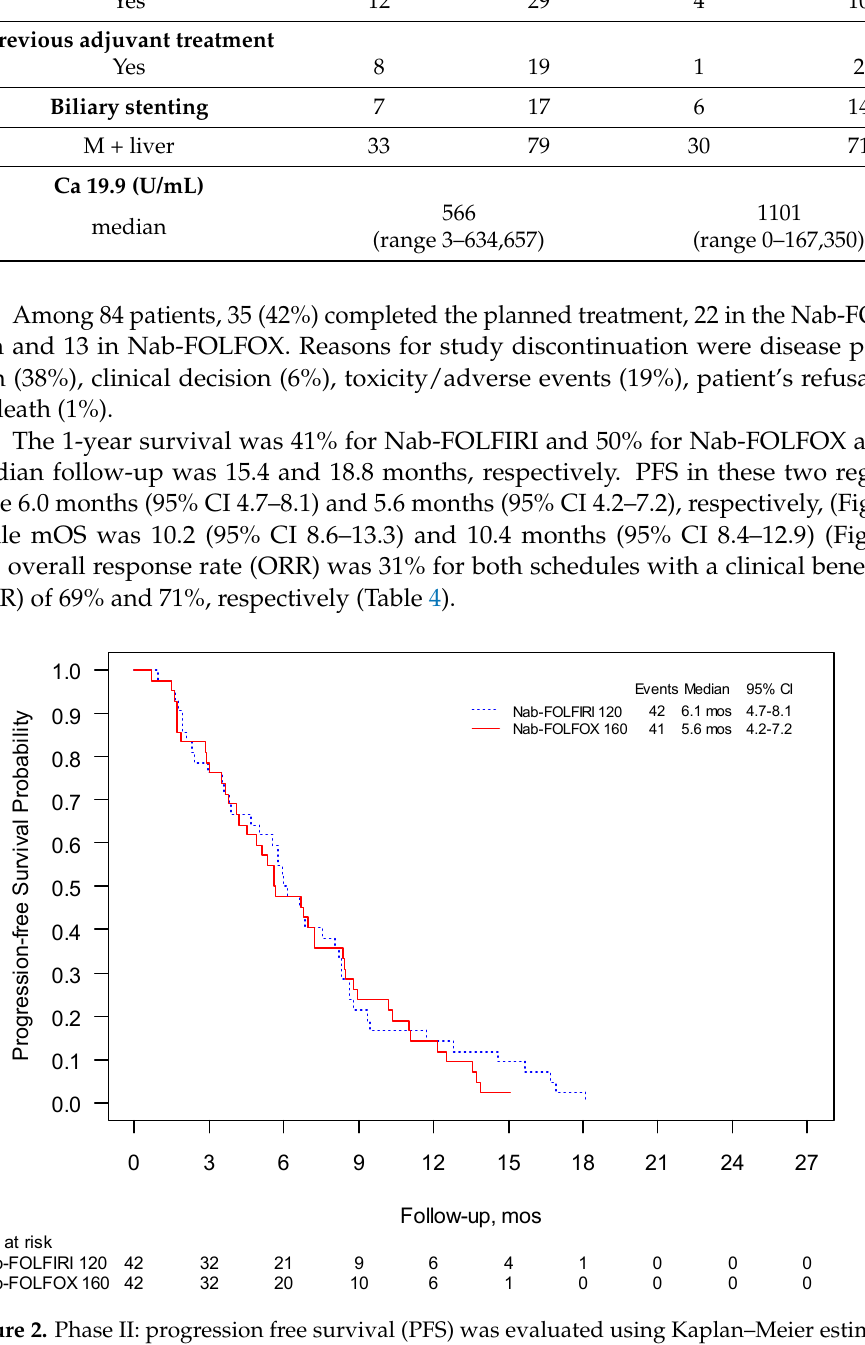
Figure 2. Phase II: progression free survival (PFS) was evaluated using Kaplan–Meier estimates of the median survival times (including 95% confidence intervals (CI)).